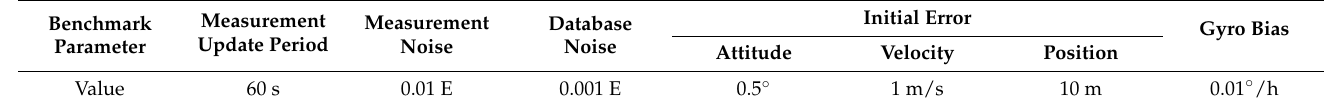
Table 1. Benchmark parameter